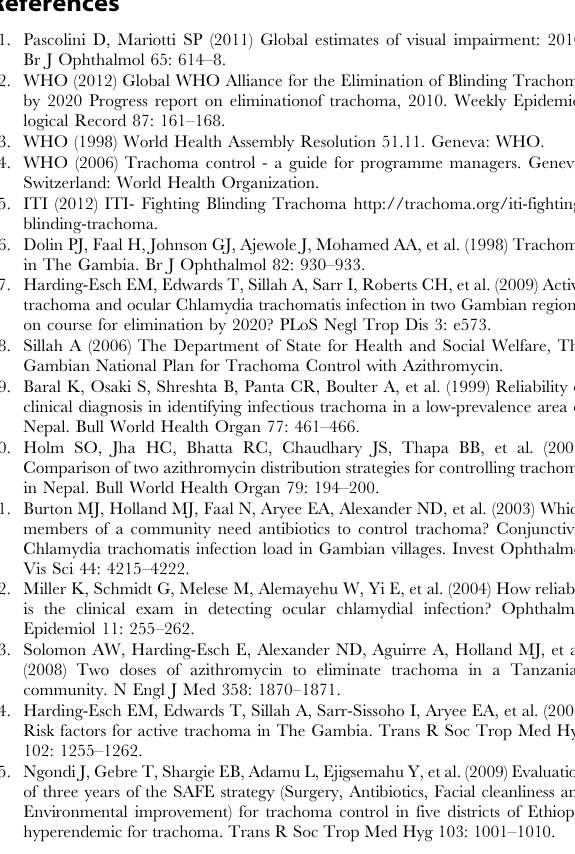
Table S2 Excel file indicating prevalence of ocular Chlamydia trachomatis (Ct) infection in each cluster at each time point. Table S3 Excel file indicating prevalence of TF in each cluster at each time